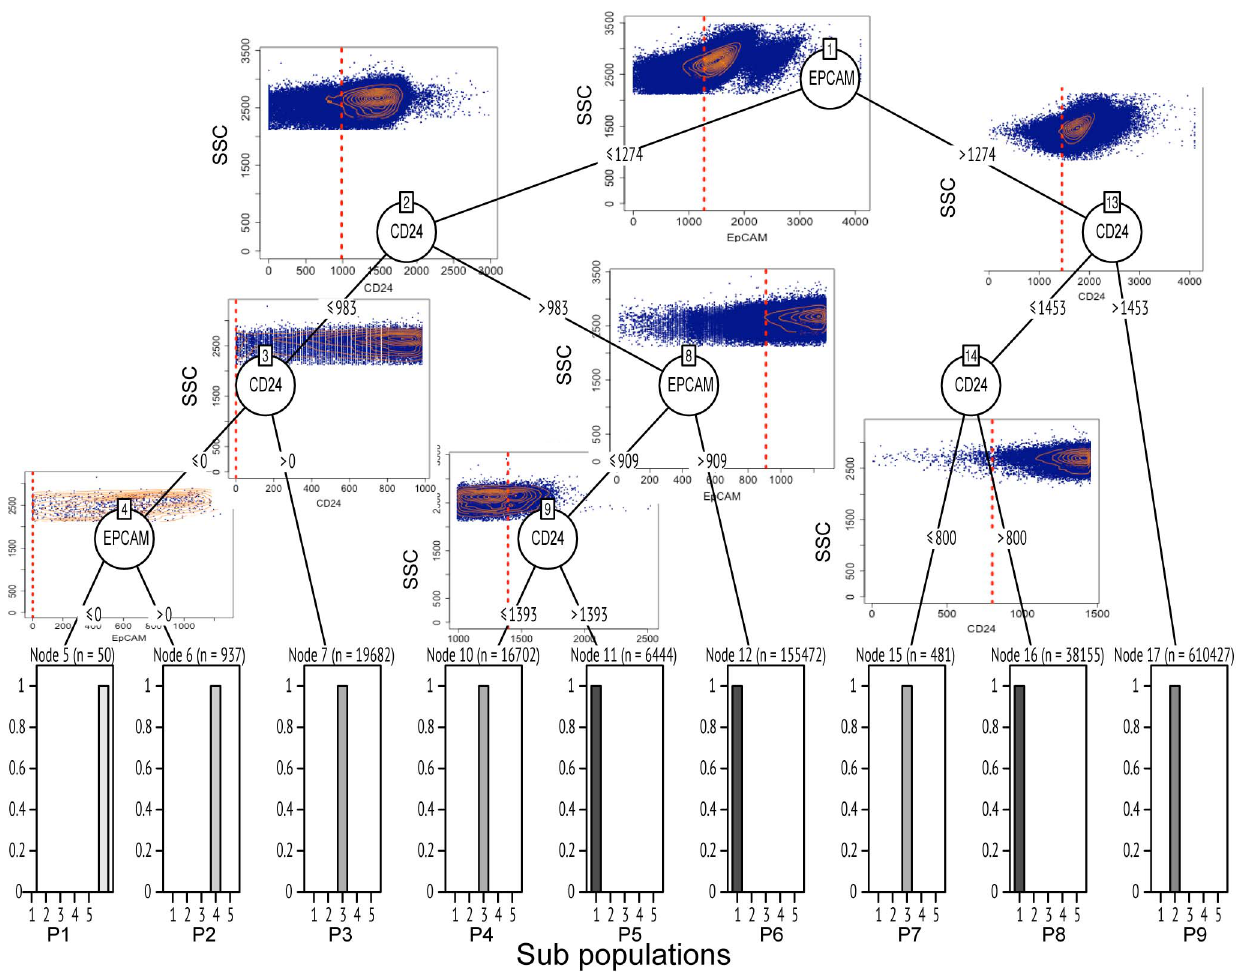
Figure 6. CCAST gating strategy on SUM159 breast cancer cell line. CCAST gating strategy for SUM159 breast cancer cell lines isolates 5 pure cell states (across 9 bins) based on CD24 and EPCAM. Visualization of these 5 subpopulations is clearly not apparent from the biaxial side scatter (SSC) vs. biomarker plots. Split point estimates (dotted red lines) go through density contour plot (orange) on the distributed data providing visual evidence for suitable cut-offs through bimodal contours. Note the split point lines for nodes 3 and 4 concentrate on the zero point mass; this indicates there are several cells with zero expression values for EPCAM or CD24 staining but with higher expression values with respect to CD44.